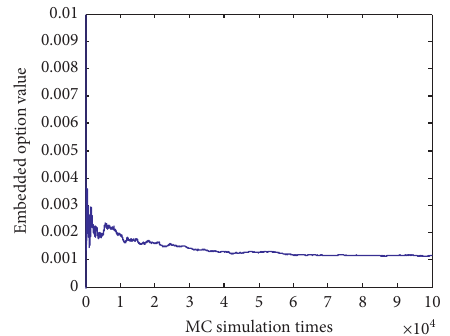
Figure 9: Simulation results of embedded option value in 5-year fixed deposit.